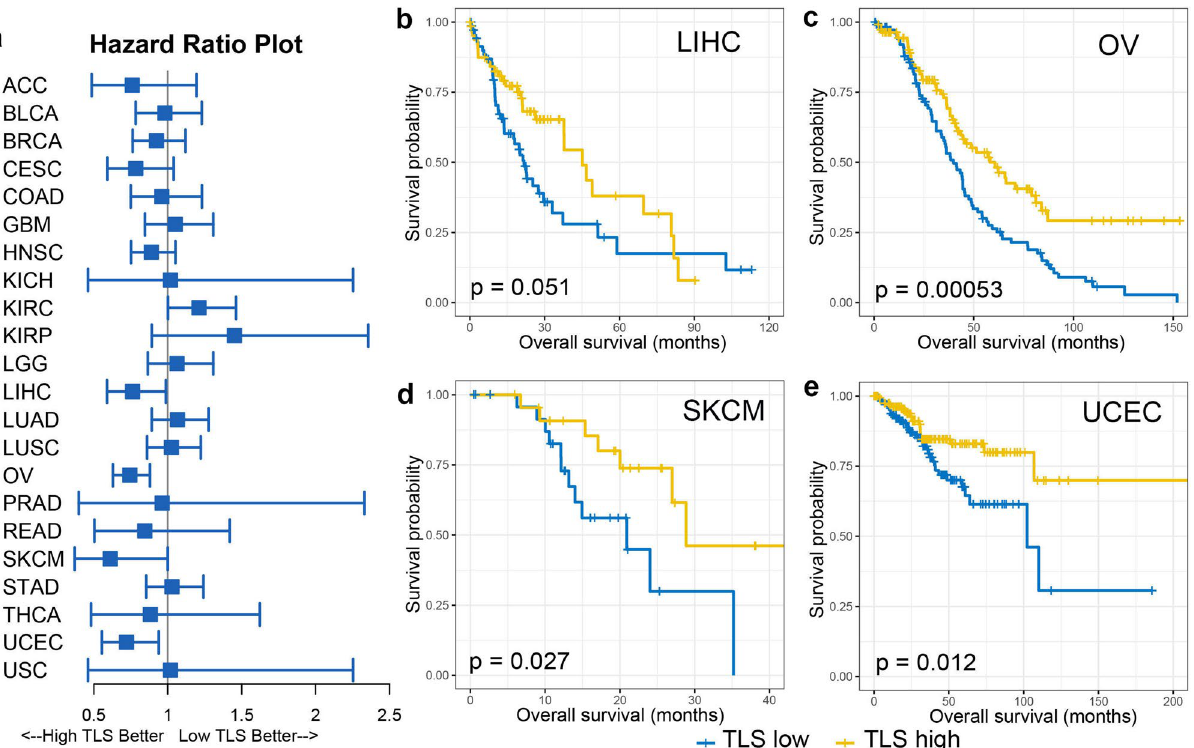
Figure 5. High TLS score associated with improved overall survival in certain tumor types. ( a ) Forest plot demonstrated the survival impact of TLS level for each tumor type. Tumors were categorized into high TLS scoring (> the second tertile), intermediate TLS scoring (between the first and the second tertile) and low TLS scoring (< the first tertile) for each tumor type. Hazard Ratio (5–95% confidence interval) were obtain by cox regression survival analysis. ( b ) Kaplan–Meier plots of overall survival difference between tumors with high TLS scoring and low TLS scoring in LIHC. ( c ) Kaplan–Meier plots of overall survival difference between tumors with high TLS scoring and low TLS scoring in OV. ( d ) Kaplan–Meier plots of overall survival difference between tumors with high TLS scoring and low TLS scoring in SKCM. ( e ) Kaplan–Meier plots of overall survival difference between tumors with high TLS scoring and low TLS scoring in